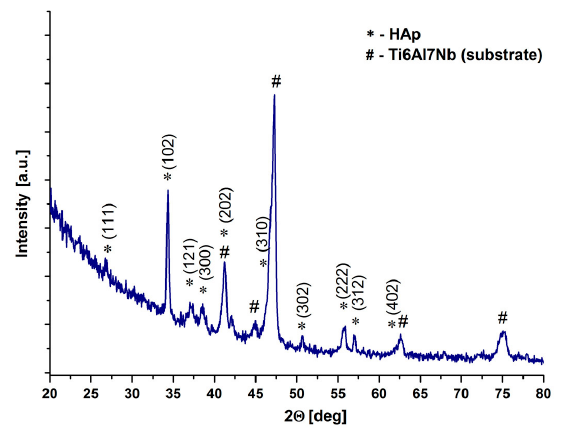
Figure 8. Diffraction pattern of HAp coating deposited on the Ti6Al7Nb alloy substrate.